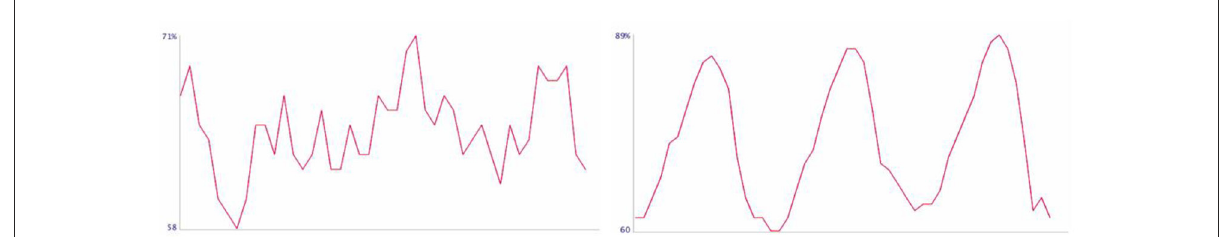
FIGURE3 The Heart Rate Variability Biofeedback (HRV-b) tool used during the experiment. The scrolling line graph depicts the most recent 45-s of the user’s heart rate wave, with the vertical-axis representing their heart rate derived from each RR interval. (Left) A typical heart rate wave during